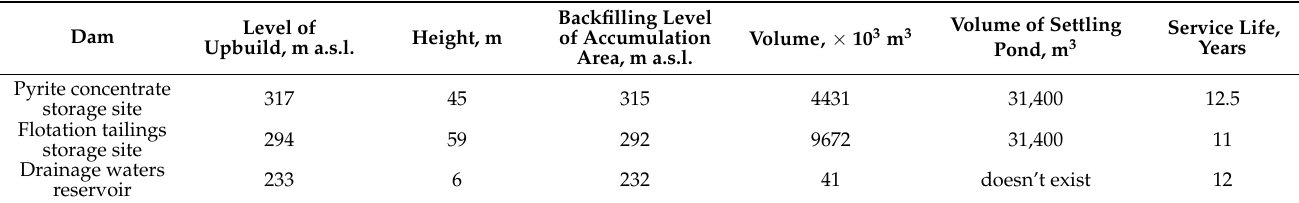
Table 1. Dimensions of the disposal sites and of the reservoir [20]. Reproduced with permission from author and publisher Mining and Metallurgy Institute Bor (MMI Bor), Serbia Zijin Mining doo Bor, Detailed Mining Design–Mineral Processing and Disposal of Tailings and Pyrite Concentrate from Cukaru Peki Deposit–Upper Zone, Bor, 2020. Dam Level of Upbuild, m a.s.l. Height,